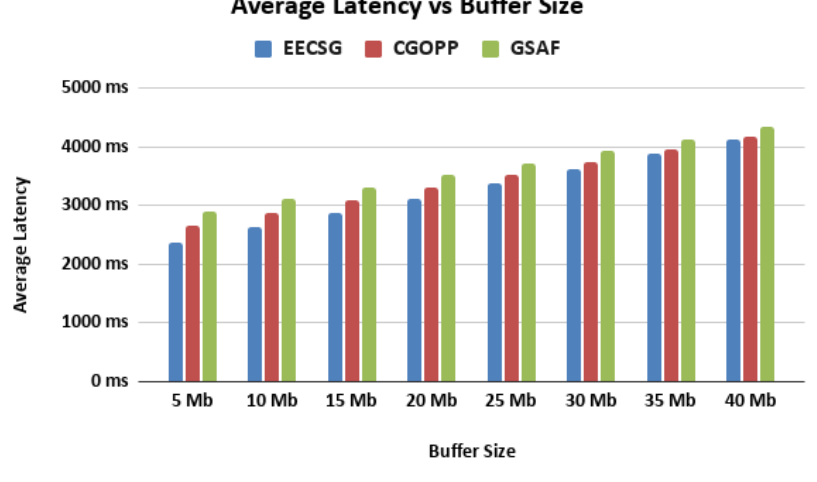
Figure 12. Average latency vs. buffer size using real data mobility traces.